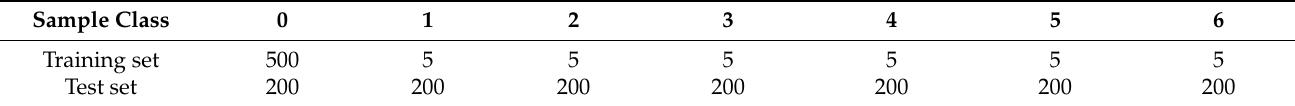
Table 6. Data settings for fault detection under imbalanced data.